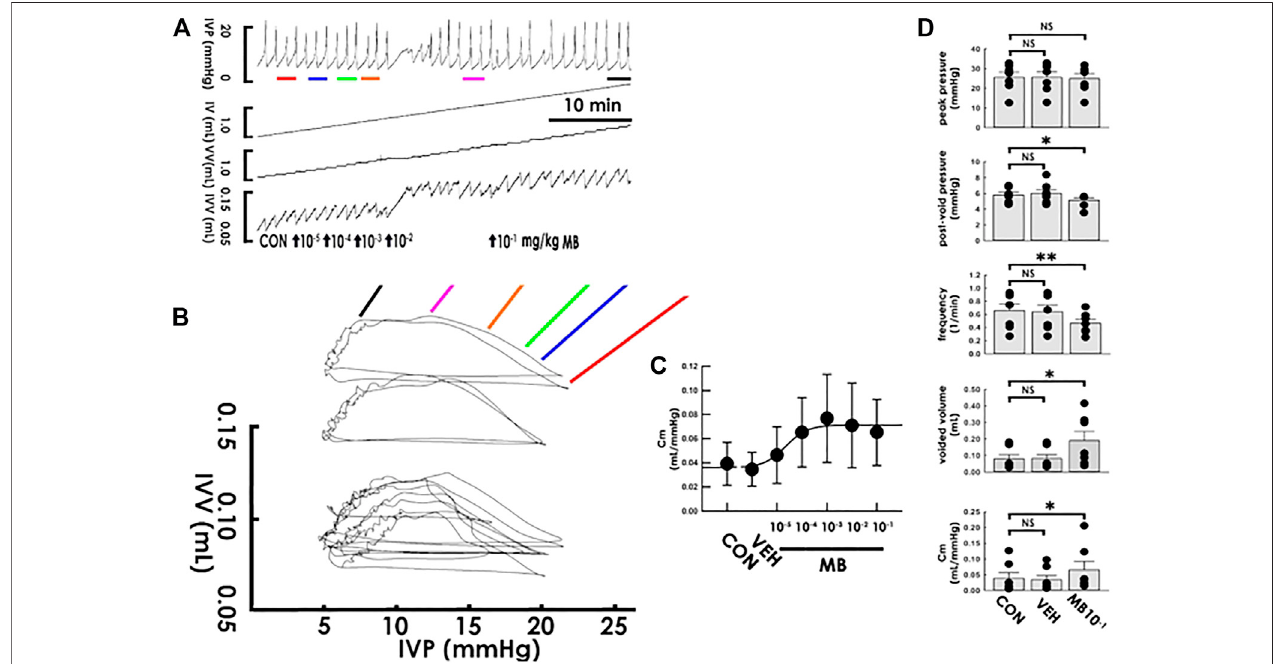
FIGURE4| Mirabegronincreasesbladdercompliance. (A) Cystometrybefore(control;CON)andfollowingintra-arterialmirabegron(MB)injectionswithincreasing concentrations(10 − 5 − 10 − 1 mg/kg,bolus).Red,blue,green,orange,pink,andblackbarsatthebottomofIVPmarkthecyclesdisplayedinthepressure-volumeanalysis. (B) Pressure-volume loops showing increasing concentrations of mirabegron progressively increases the slope of the regression line of the fi lling phase. (C) Dose- response analysis showing mirabegron step-wisely increases the mean compliance (Cm) with an ED 50 at about 2.2 × 10 − 5 mg/kg. (D) While vehicle solution (VEH) displays no statistical difference in parameters, injection of mirabegron (1 × 10 − 1 mg/kg; MB1X10 − 1 ) signi fi cantly decreases the post-void pressure and voiding frequency but increases voided volume and Cm (* p < 0.05, ** p < 0.01, vs. CON; all n (cid:2) 7). IVP: intra-vesical pressure, IV: infused volume, VV: voided volume, IVV intra- vesical